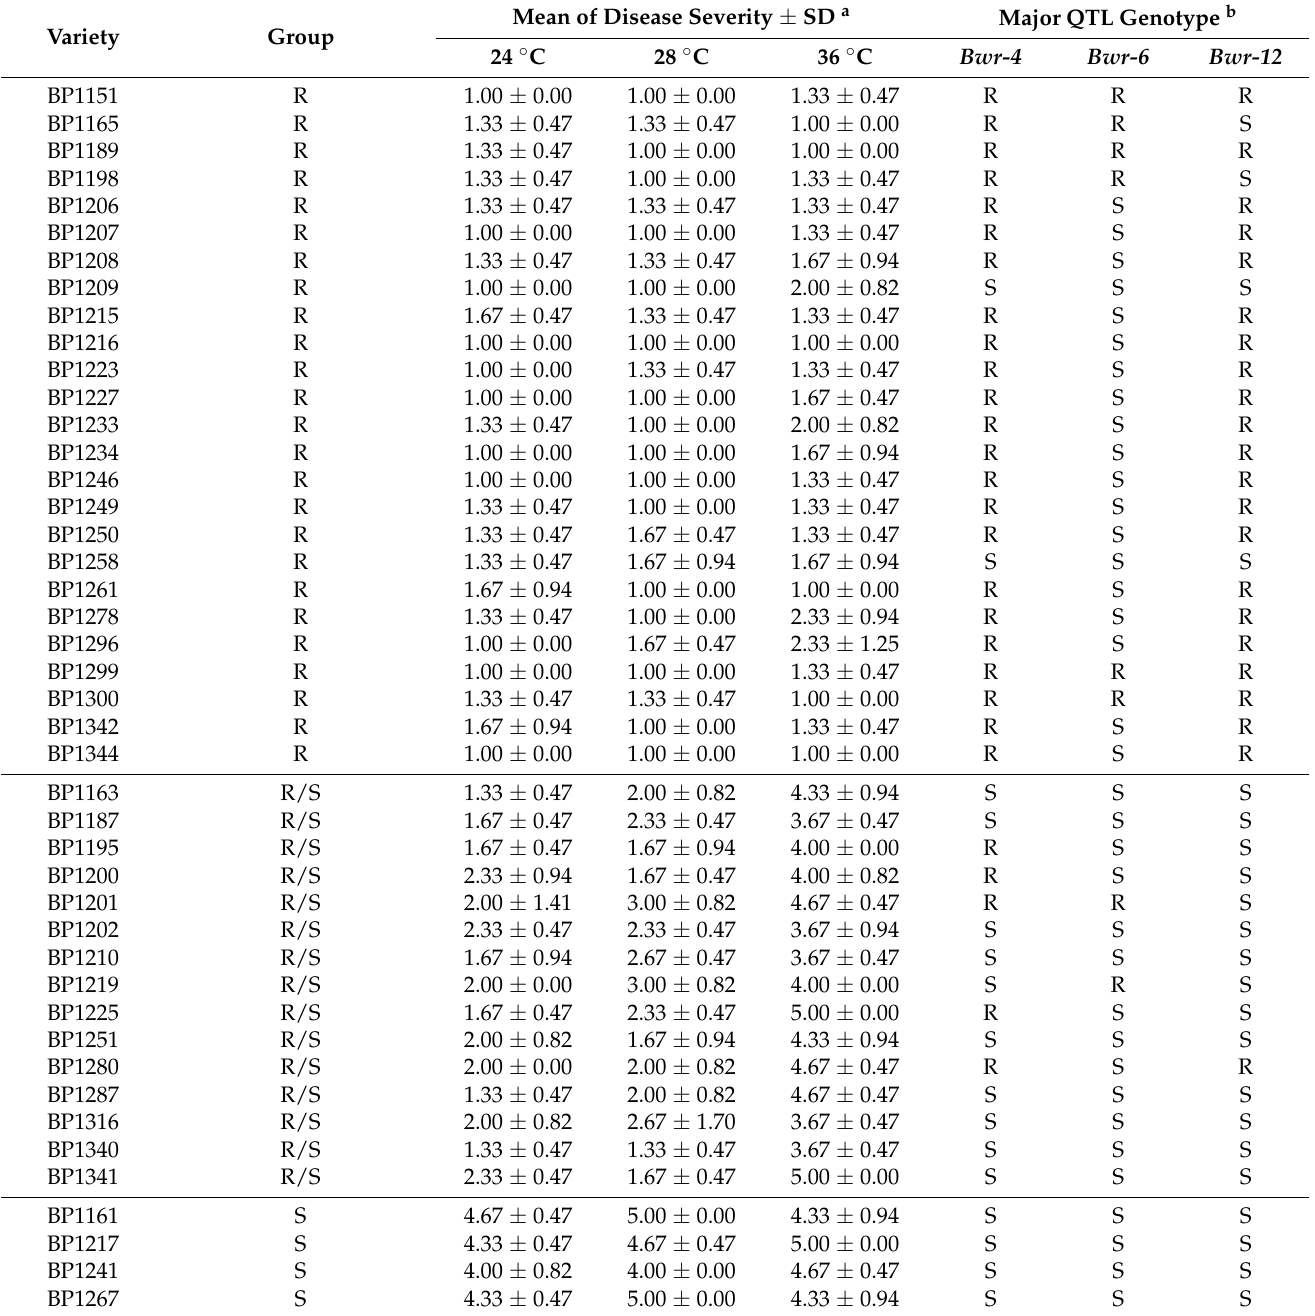
Table 3. Disease severity and genotypes of 50 tomato varieties for three major QTL associated with bacterial wilt resistance.